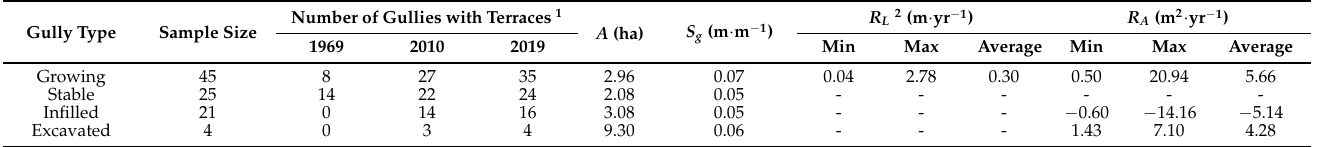
Table 3. Information of investigated gullies.